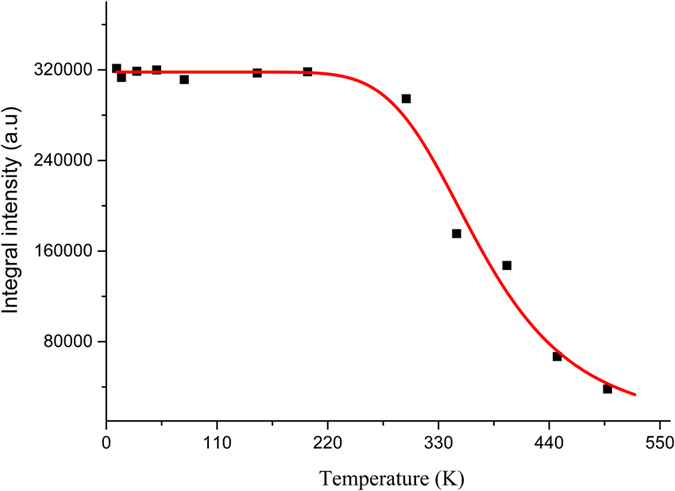
Temperature dependence of the integral emission intensity of 2 at% Eu3+-doped Bi4Si3O12 phosphors excited by 271 nm (squares) and the result of the fitting according toEq. (4)
(solid line).